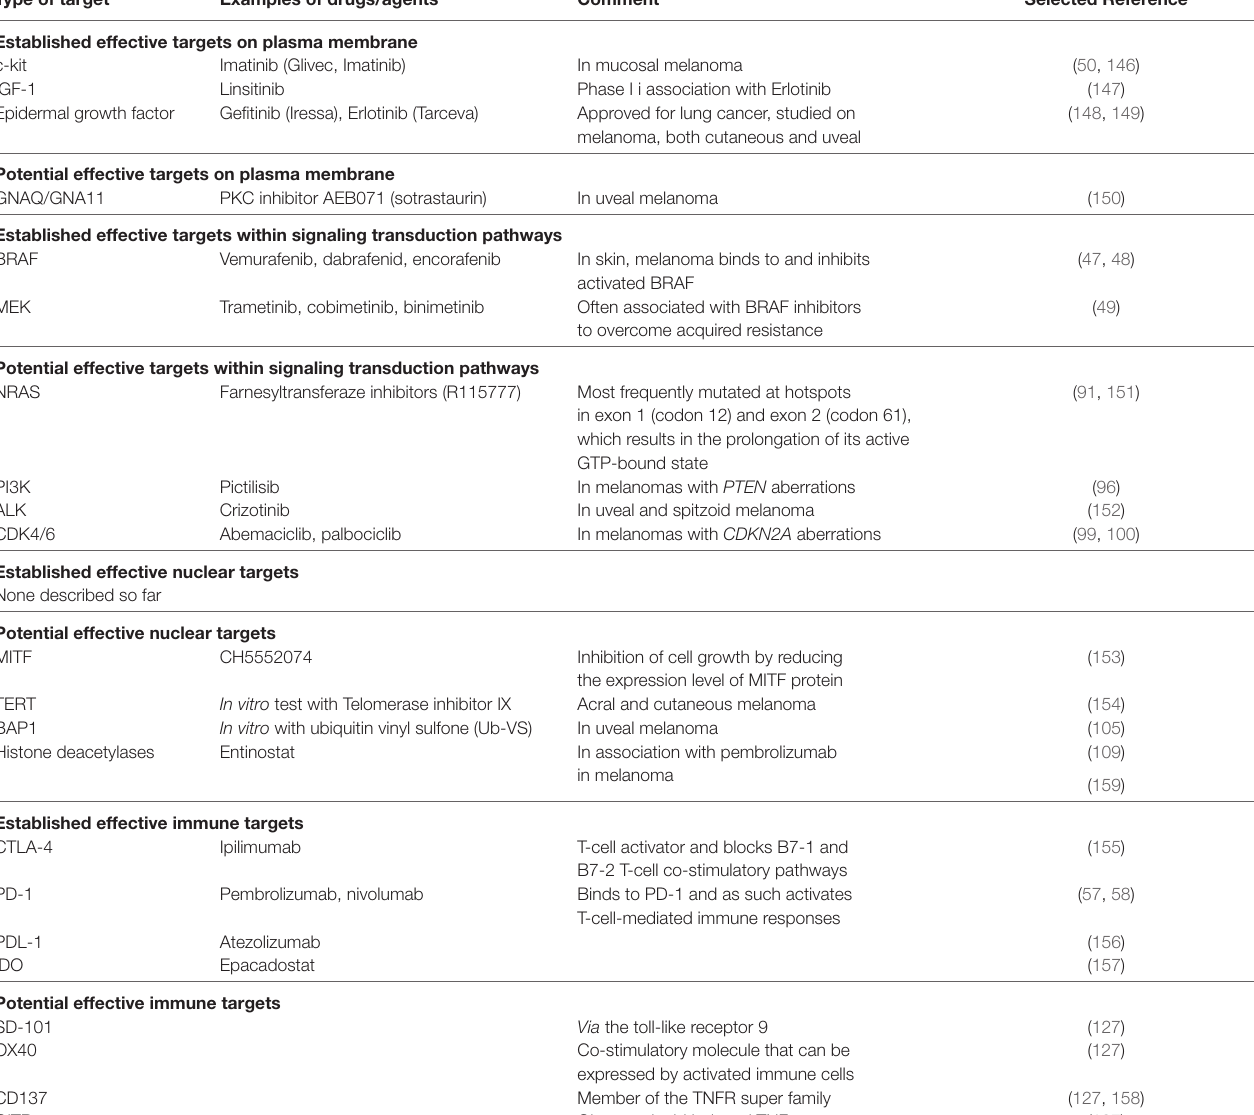
TABLe 1 | Established and potential targets for the treatment of melanoma and their level of